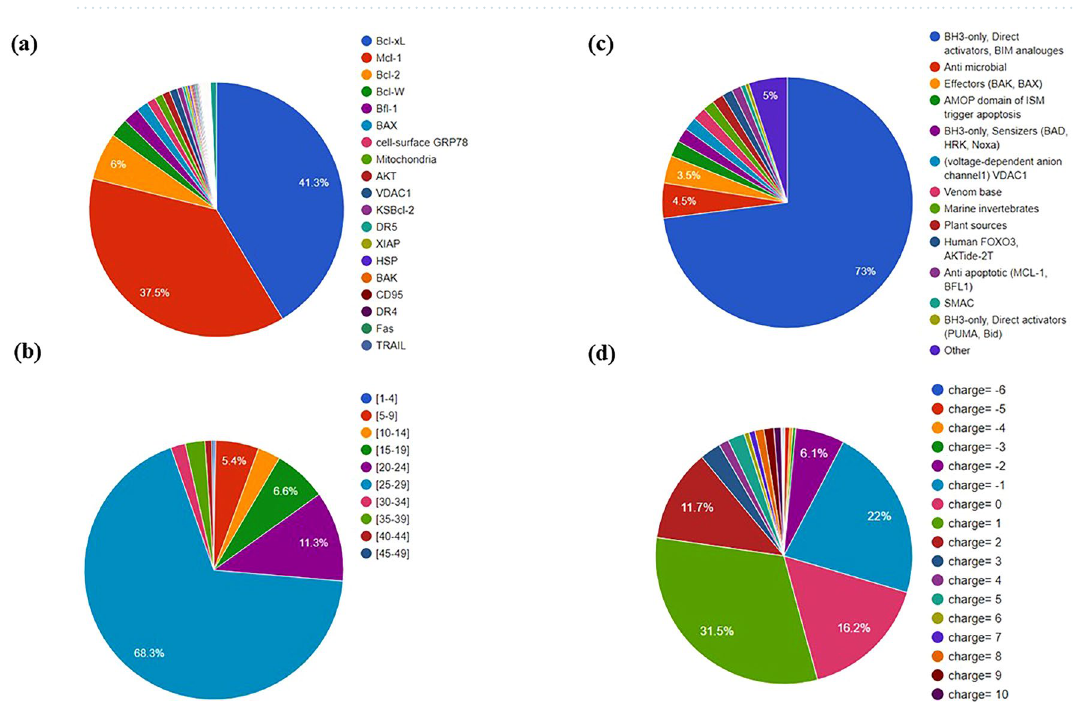
Figure 4. Representation of distribution based on ( a ) binding target, ( b ) length, ( c ) source and ( d ) charge in